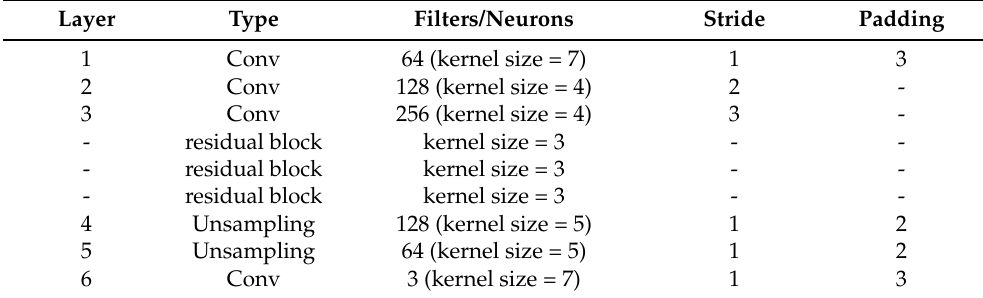
Table 3. Structural parameters of the generator.